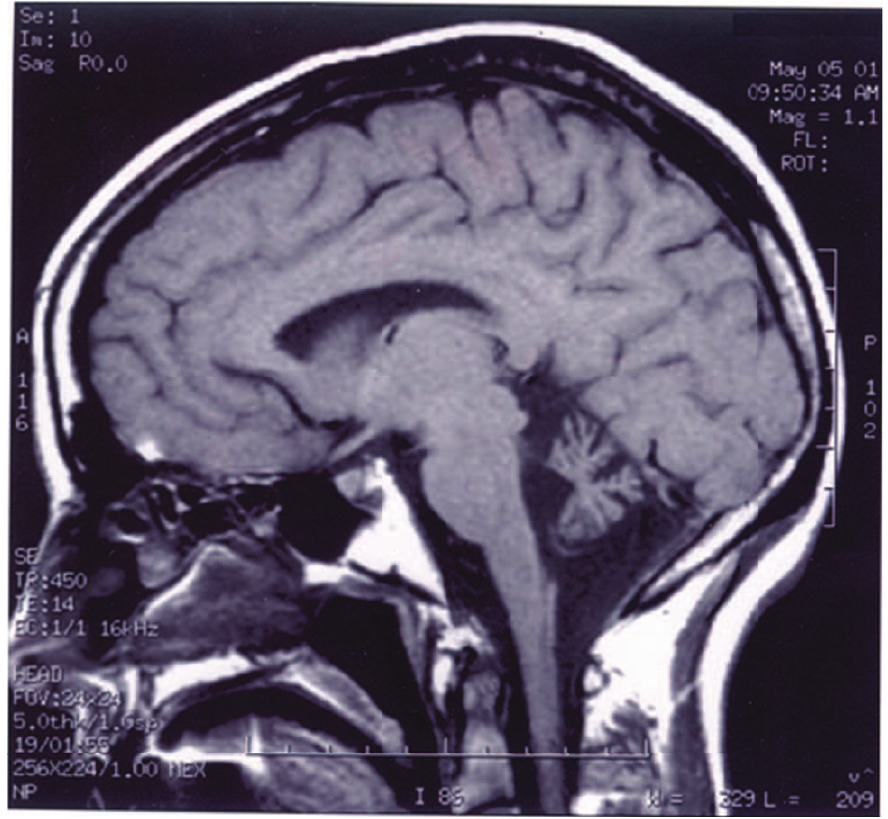
Figure 2. MRI of Patient with the p.Arg423His mutation. Cerebellar atrophy in a 48 year old female (H2591) with ataxia and the KCNC3 Arg423His mutation. Midsagittal T1-weighted MRI of the brain shows a small atrophic cerebellum with a normal appearing